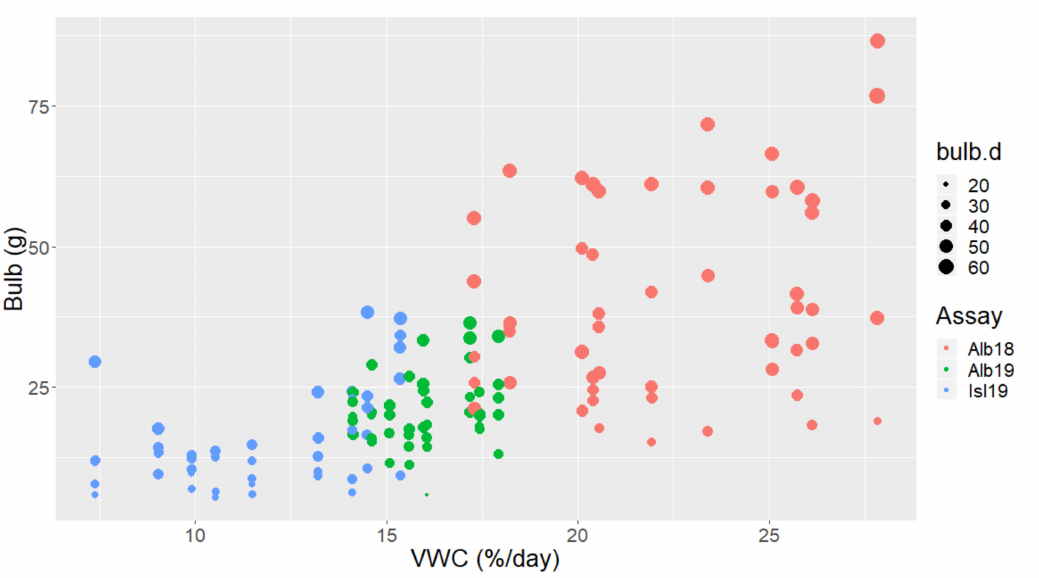
Figure 5. Scatterplot of final bulb biomass at each assay along a gradient of soil volumetric water content. Blue points correspond to Isl 19 ; green points to Alb 19 and red points to Alb 18 . The di ff erent sizes of the points are related to the bulb diameter